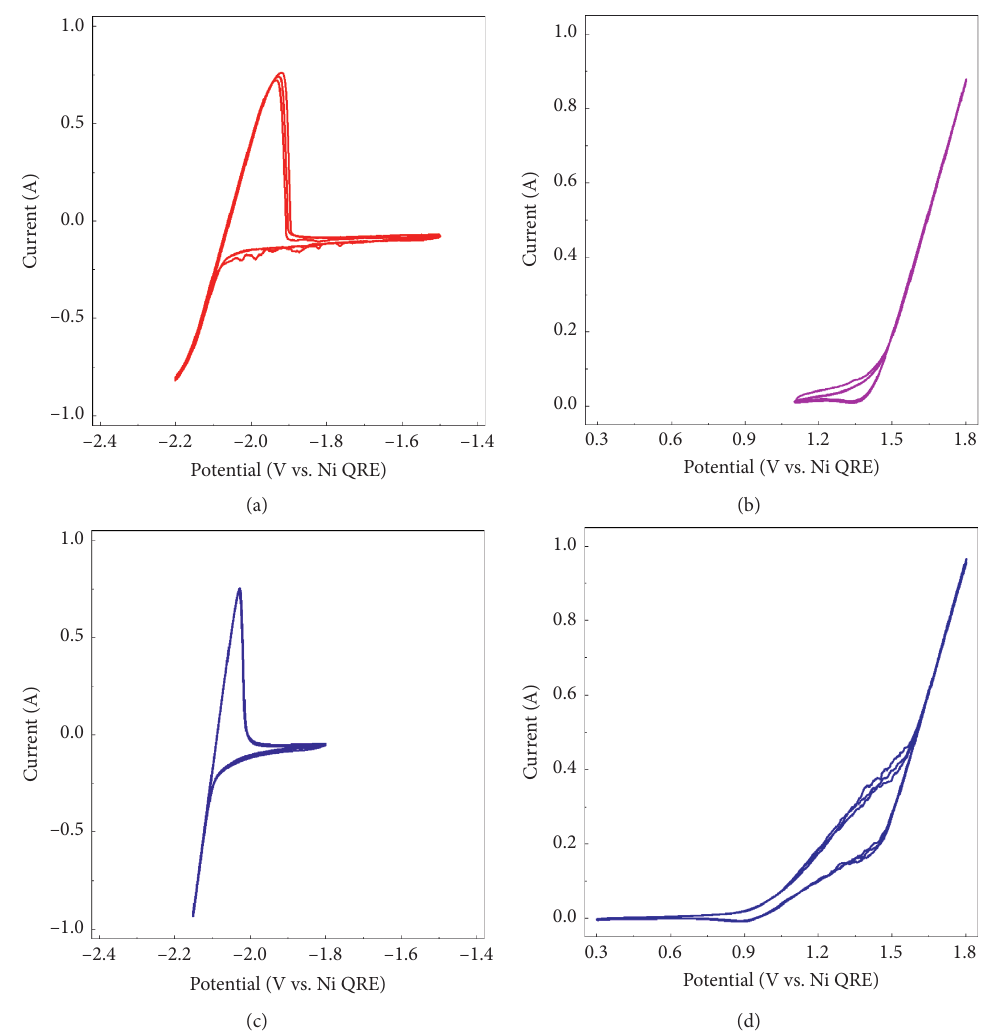
Figure 5: CV investigation of the (a, b) LiCl and (c, d) LiCl-CsI molten salts for the (a, c) cathode and the (b, d)